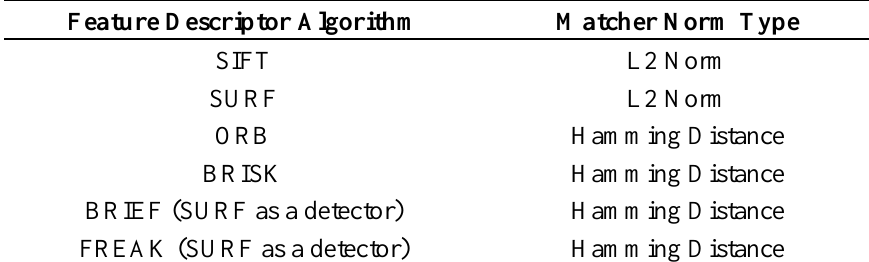
Table 1. Algorithms evaluated in the